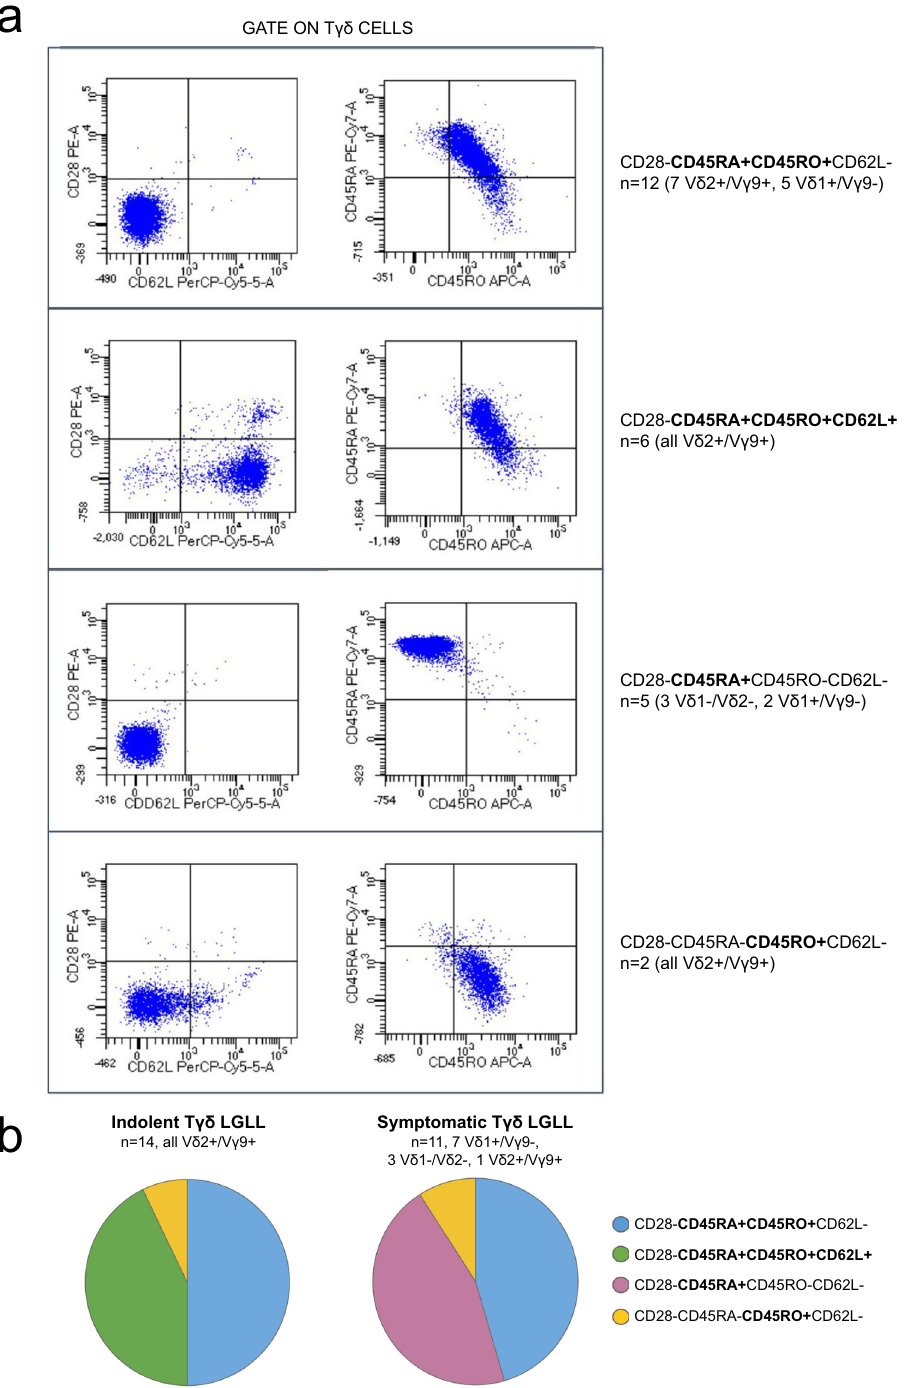
Fig. 3 FACS analysis for markers determining the T lymphocyte maturation phase of leukemic clones, CD28, CD45RA, CD45RO and CD62L. a Two panels representative for the 4 phenotype combinations found among the T γδ LGLL cases are reported. b The pie charts indicate the distribution of the 4 phenotypes in the patients divided in indolent and symptomatic T γδ LGLL. LGLL: large granular lymphocyte